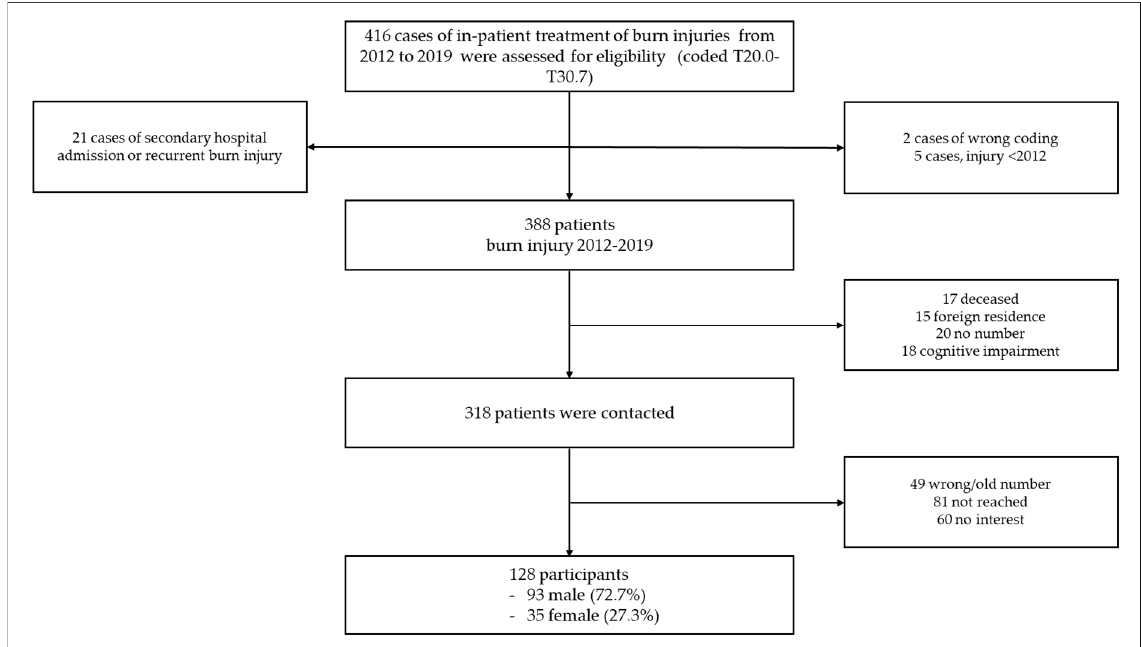
Figure 1. Flowchart outlining the selection of participants.